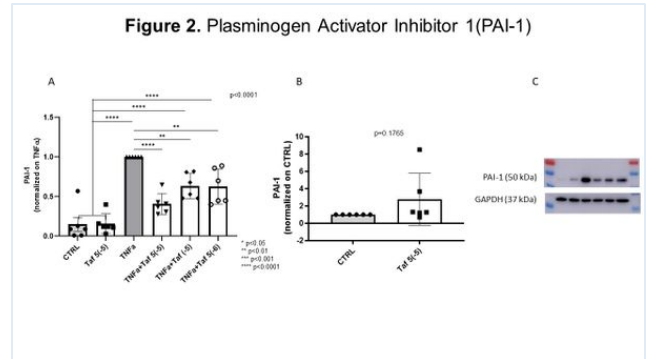
Figure 1. Expression of Tissue Factor (TF) in human aortic endothelial cells (HAECs) treated with increasing concentrations of tafamidis (Taf) after stimulation with TNFα (A) or at baseline (B). Representative western blot